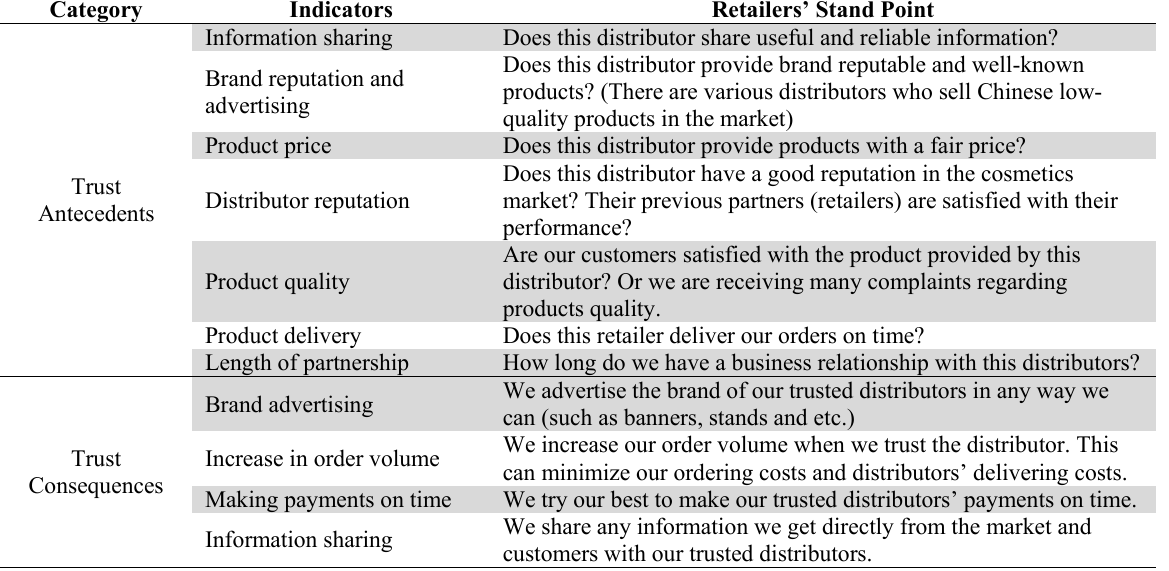
Trust antecedents and consequences of cosmetics